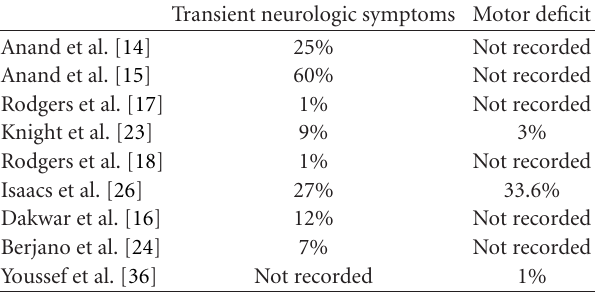
Table 1: Summary of published neurologic XLIF